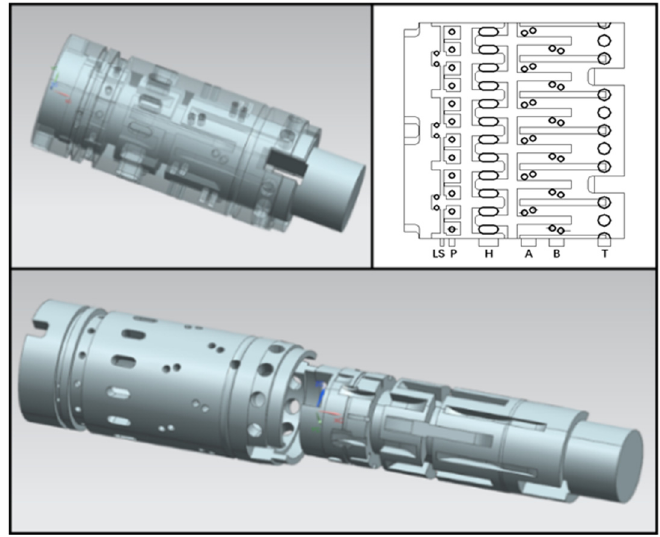
Figure 2. Relation diagram of valve core and valve sleeve.